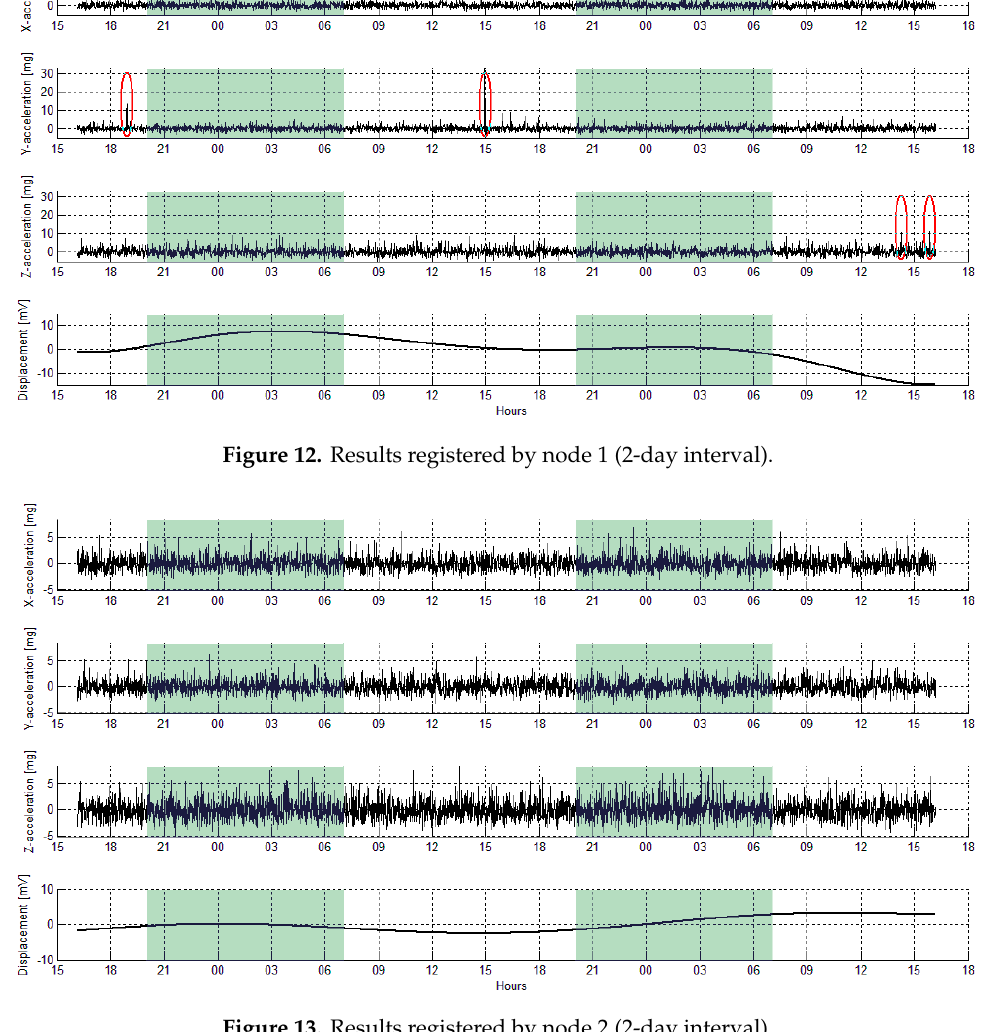
Figure 15. Results registered by node 4 (2-day interval). The reliability of the information flow in the system was analyzed on the basis of the frequency of transmission errors. LoRa systems based on Semtech Sx1276/1277/1278 chipsets can be programmed for a fixed number of repetitions of attempts to establish contact, as well as time intervals for renewing transmissions. Nevertheless, it may happen that an attempt to establish contact will be unsuccessful, which is manifested by a lack of record in the collected data set (Figure 16). The occurrence of such errors in the records was negligible and did not exceed 0.1% of the volume of collected data.